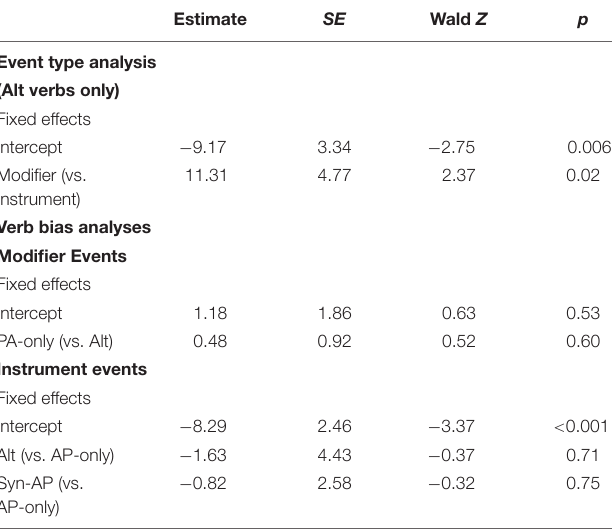
TABLE 3 | Mixed models of the likelihood of a PA order response in Experiment